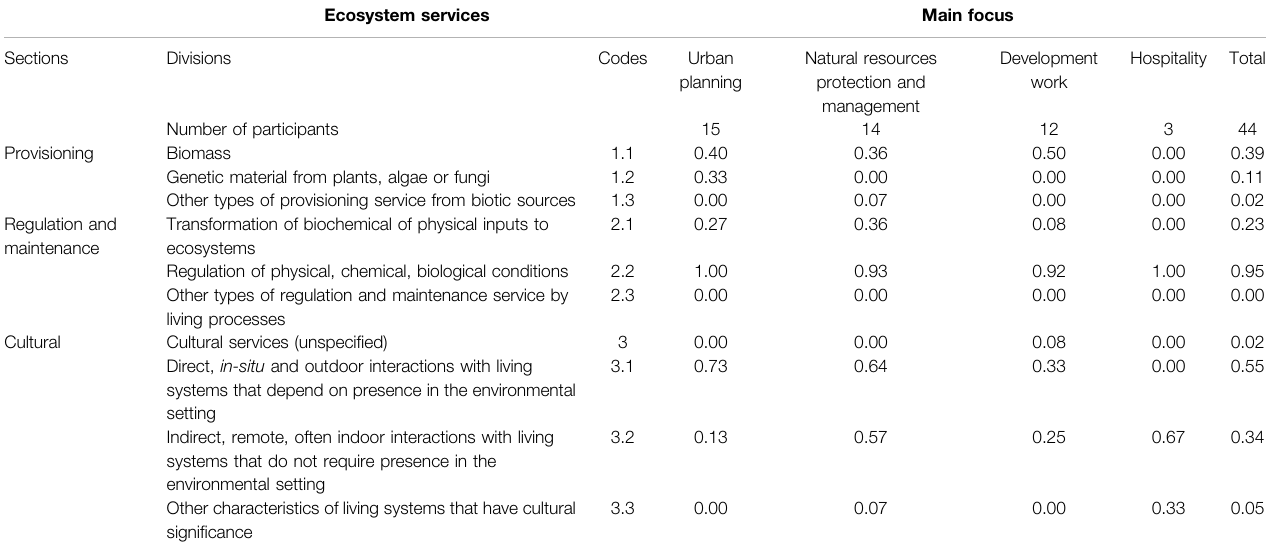
TABLE 2 | Proportion of stakeholders with each focus identifying each CICES ecosystem services division. Light shading indicates proportions closer to zero, representing low recognition of the challenge, whereas darker shading indicates proportions closer to one, representing high